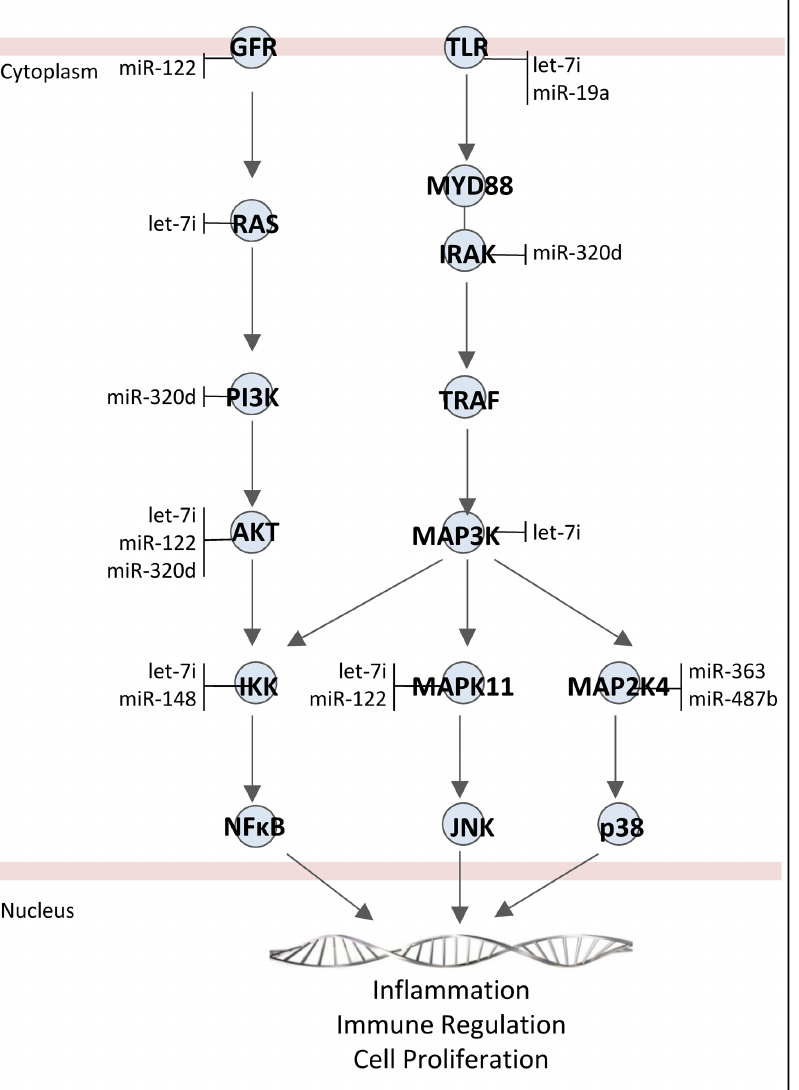
Figure 2. Genes and their microRNA targets in the NF- k B and toll-like receptor signaling pathways. microRNA were identified in the current study as differentially expressed in ischemic stroke, and are predicted to target genes based on prior observation or high predicted probability. Abbreviations: GFR, Growth factor receptor; IKK, Inhibitor of nuclear factor kappa-B kinase; IRAK, Interleukin-1 receptor-associated kinase; MAPK, Mitogen-activated protein kinase; MYD88, Myeloid differentiation primary response 88; PI3K, Phosphatidylinositide 3-kinase; TLR, Toll like receptor; TRAF, TNF receptor associated factor.